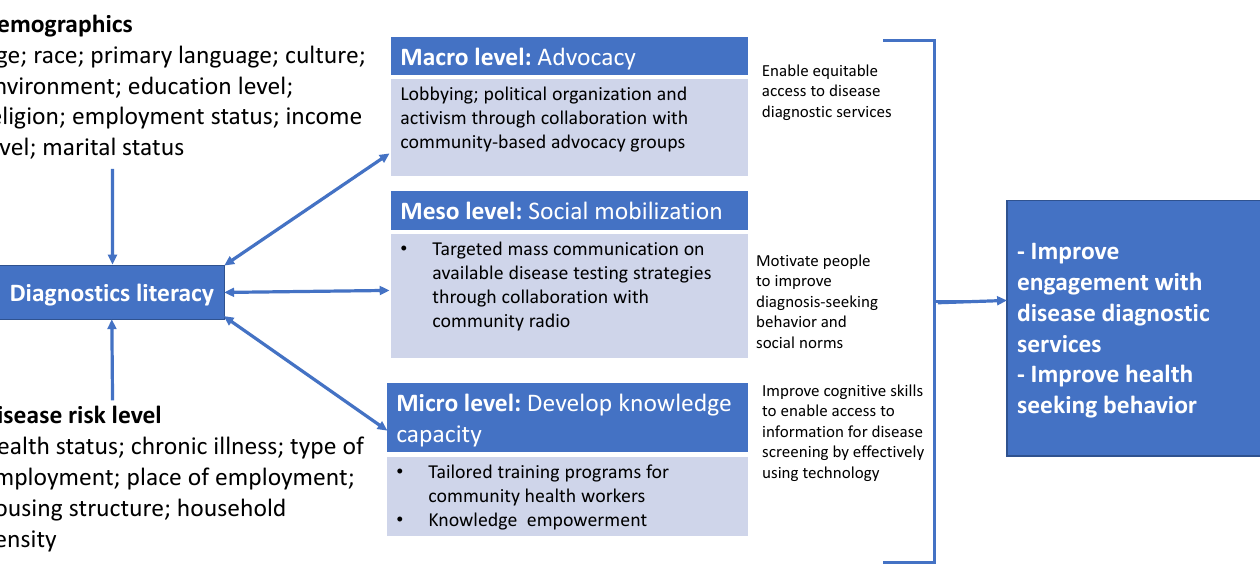
Figure 1. Multi-level diagnostics literacy advocacy